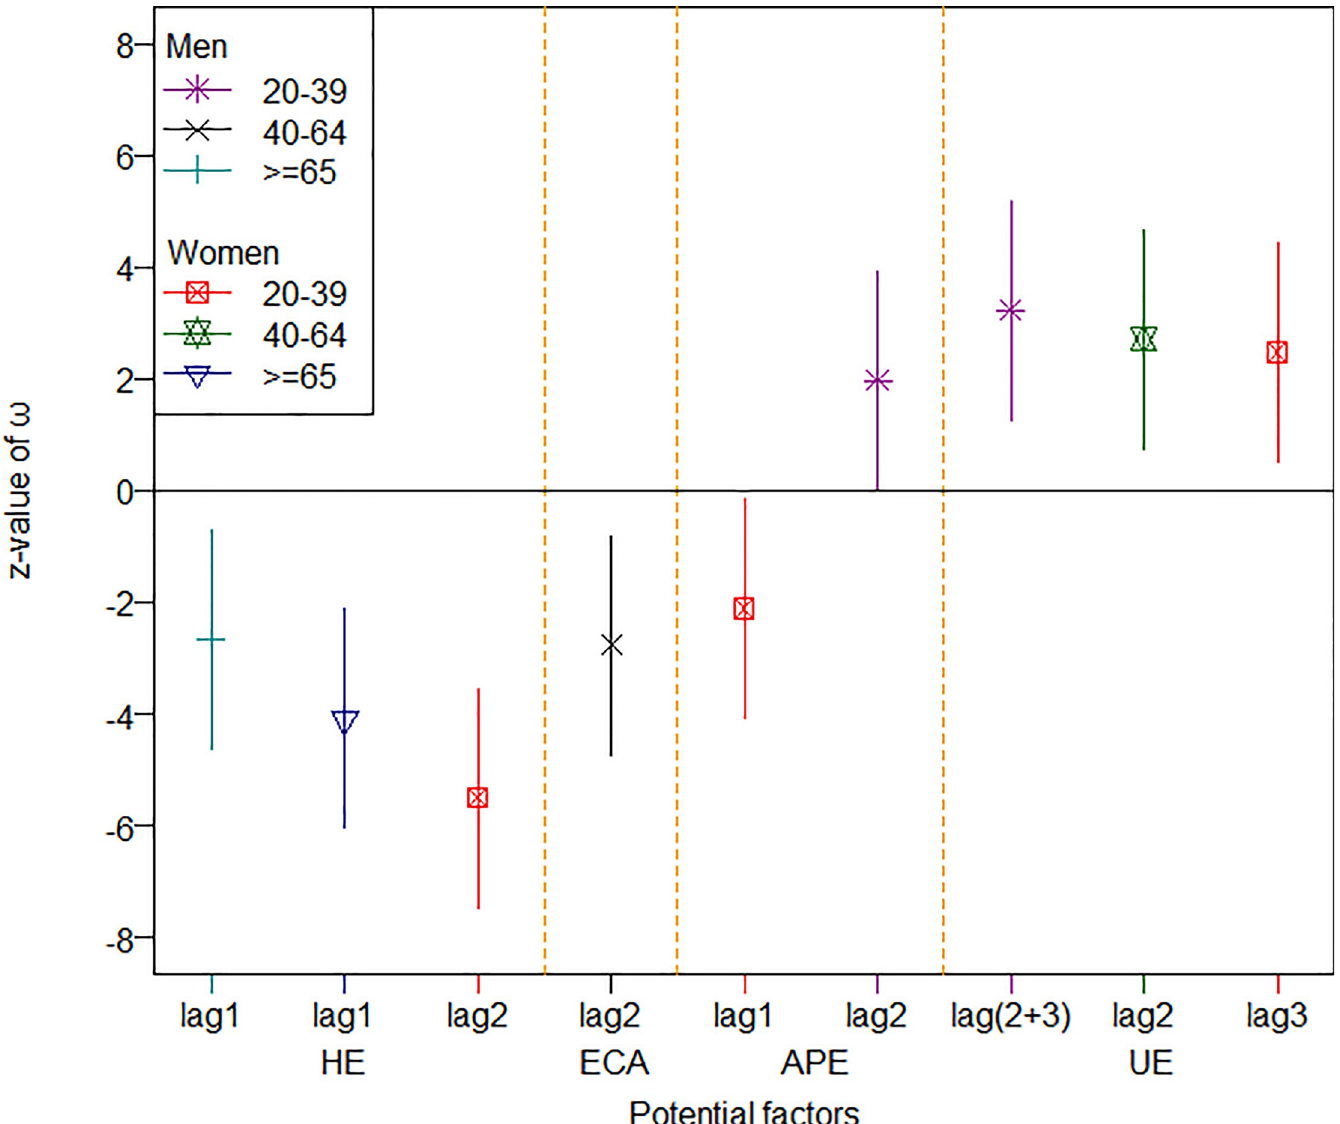
Fig 1. The effects of significant factors on incidence of ischemic heart diseases. The indicator and solid line present the z-value and 95% coefficient interval of ω , respectively; the lag with a bracket represents the integrated effect for two different lags with an increasing